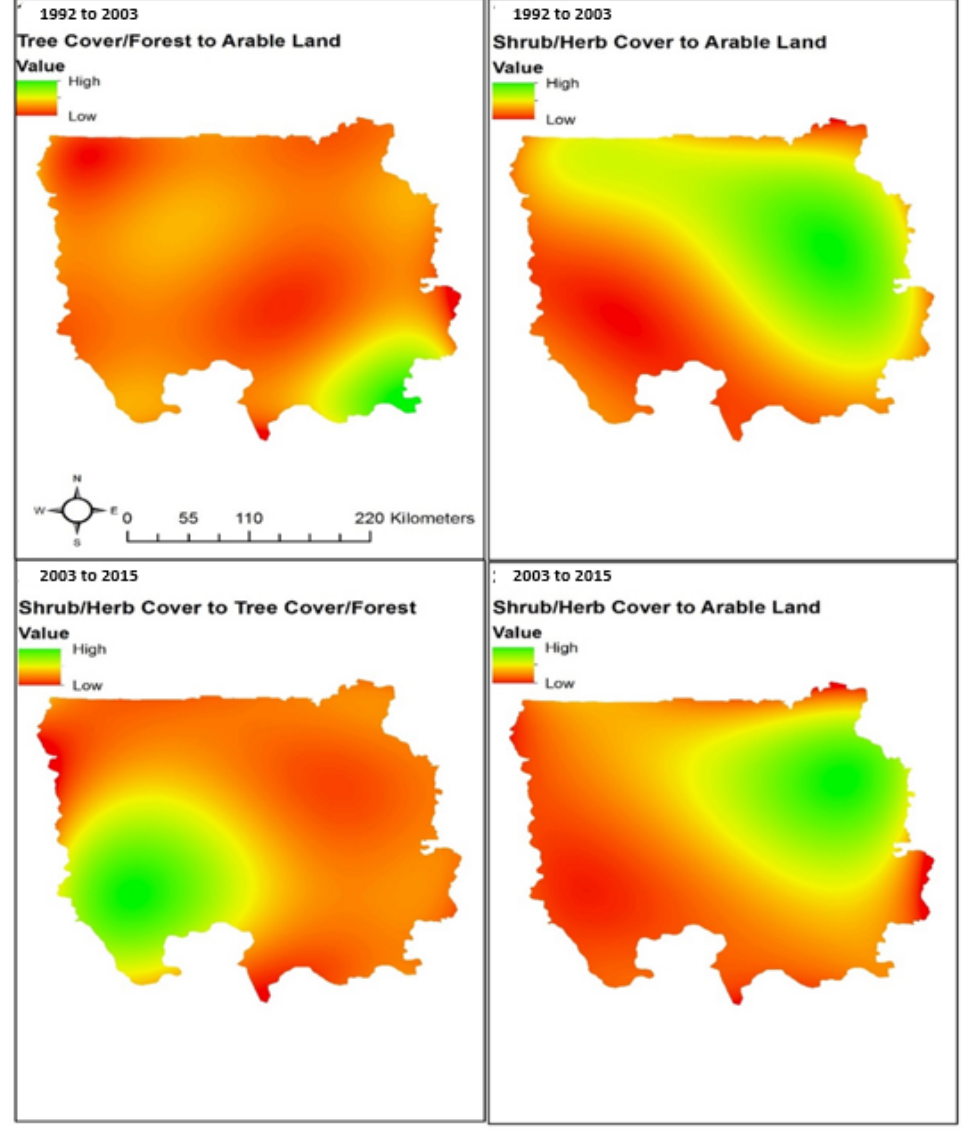
Figure 5. Maps of spatial trend of change showing major land-use transitions in the study area during 1992–2003 and 2003–2015.